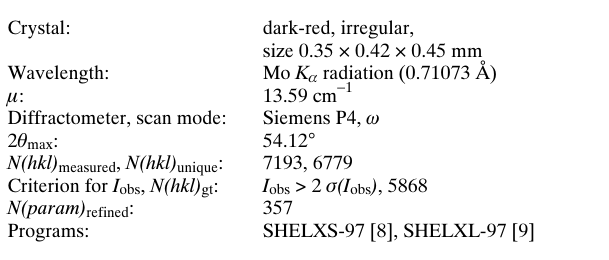
Table 1. Data collection and